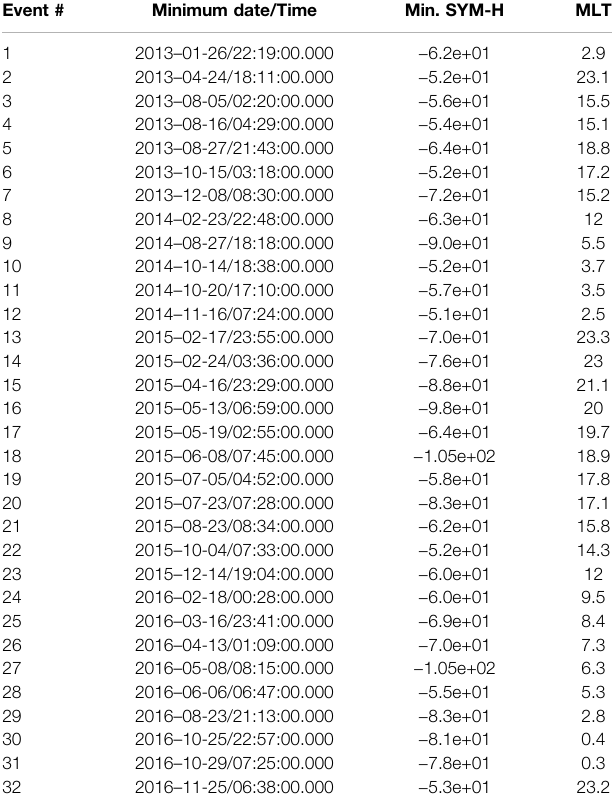
TABLE 3 | From left to right: number, Date and time, minimum Sym-H index (i.e., high resolution Dst index) and MLT of the apogee of probe B of the Van AllenProbesforeachofthe32highspeedstreamsbetweenSeptember2012and December 2016 of this study (reported from the selection of the HSS events of Turner et al.